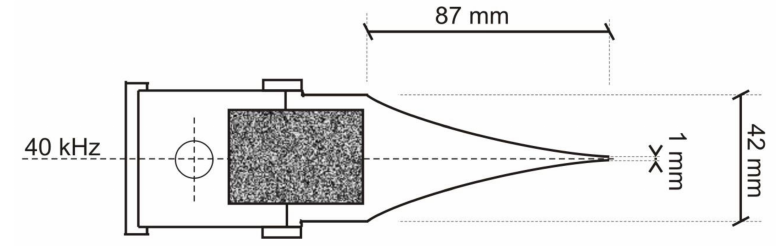
Figure 4. Ultrasonic spot head with the exponential